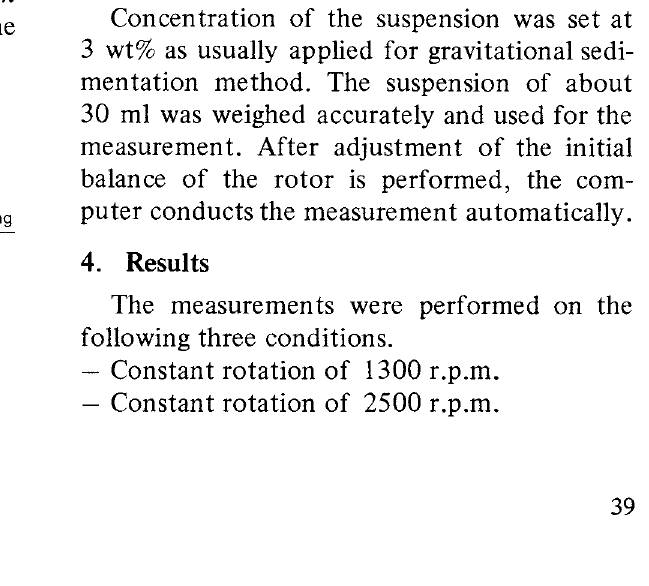
Fig. 5 Dimensions of the rotor and the cell